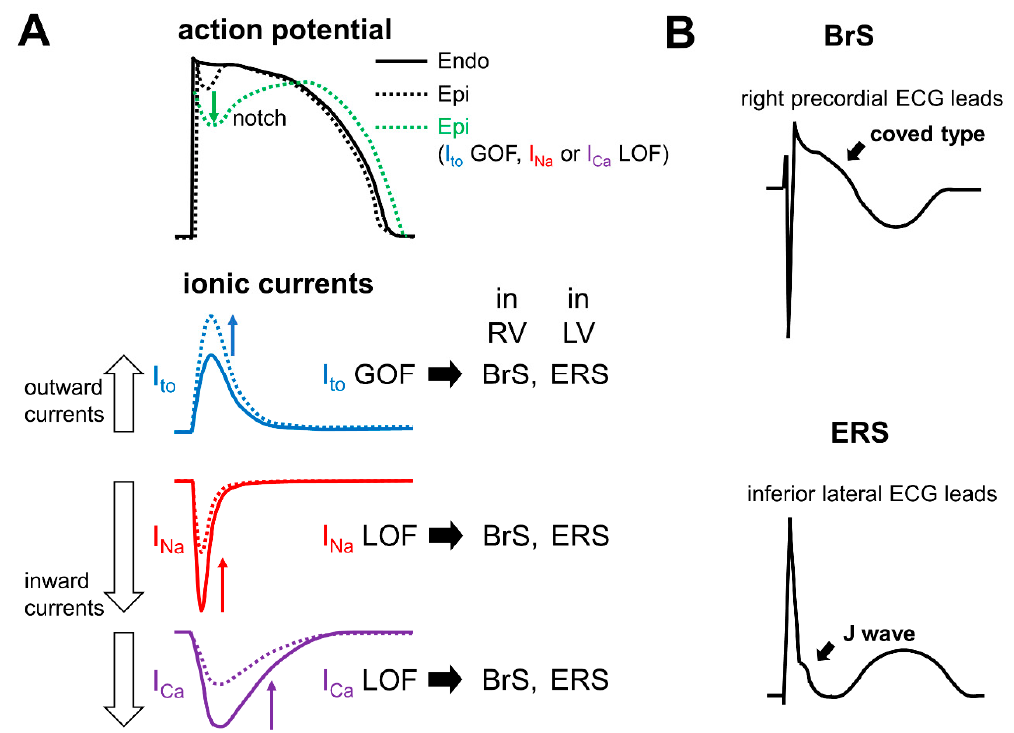
Figure 1. Schematic representation of the ionic mechanisms underlying Brugada syndrome (BrS) (coved-type ST segment elevations in the right precordial ECG leads) and early repolarization syndrome (ERS) (J waves in inferior and lateral ECG leads). ( A ) The upper panel shows the schematic representation of the ventricular action potentials (APs) in endocardium (solid line), epicardium with an AP notch (dotted line), and epicardium with an enhanced AP notch (green dotted line). Adapted from Antzelevitch. [112]. The lower panel shows the schematic representation of the major ionic currents that contribute to the early phase of ventricular AP. I to (blue solid line), I Na (red solid line), and I Ca (purple solid line) are shown. The gain-of-function of I to (blue dotted line), loss-of-function of I Na (red dotted line) or I Ca (purple dotted line) can theoretically produce an AP notch (green dotted line in A). ( B ) Schematic representation of ECGs of BrS and ERS. An enhanced AP notch at the right ventricular (RV) wall can theoretically induce coved-type ST segment elevations in the right precordial ECG leads (upper panel), while an enhanced AP notch at the left ventricular (LV) wall can theoretically produce J waves in the inferior and lateral ECG leads (lower panel). BrS: Brugada syndrome; ECG: Electrocardiogram; Endo: Endocardium; Epi: Epicardium; ERS: Early repolarization syndrome; GOF: Gain-of-function; I Ca : Voltage-gated L-type calcium channels/currents; I Na : Voltage-gated sodium channels/currents; I to : Transient outward potassium currents; LOF: Loss-of-function; LV: Left ventricle; RV: Right ventricle.